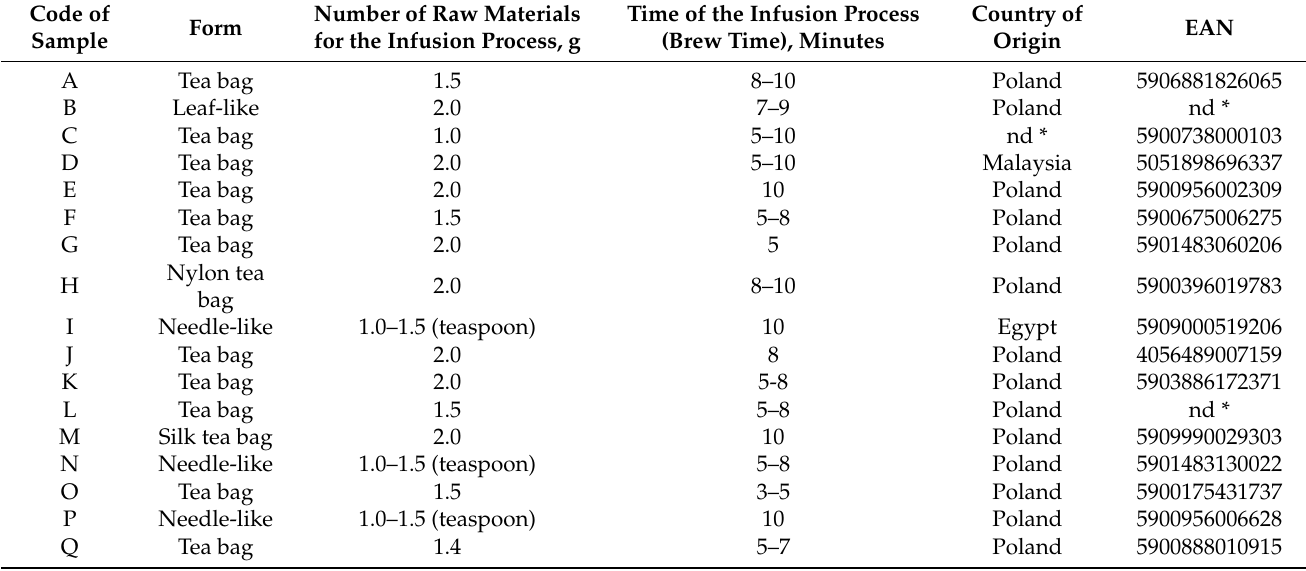
Table 1. The characteristics of investigated mint tea